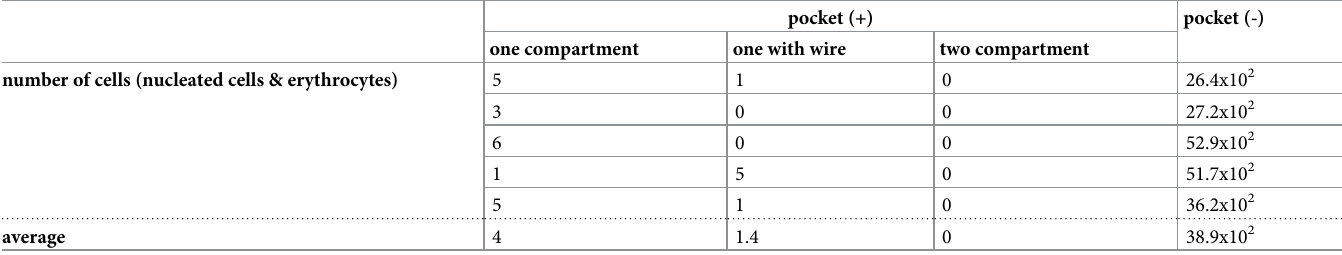
Table 6. Wrapping effects according to pocket compartment design in FFPE tissue